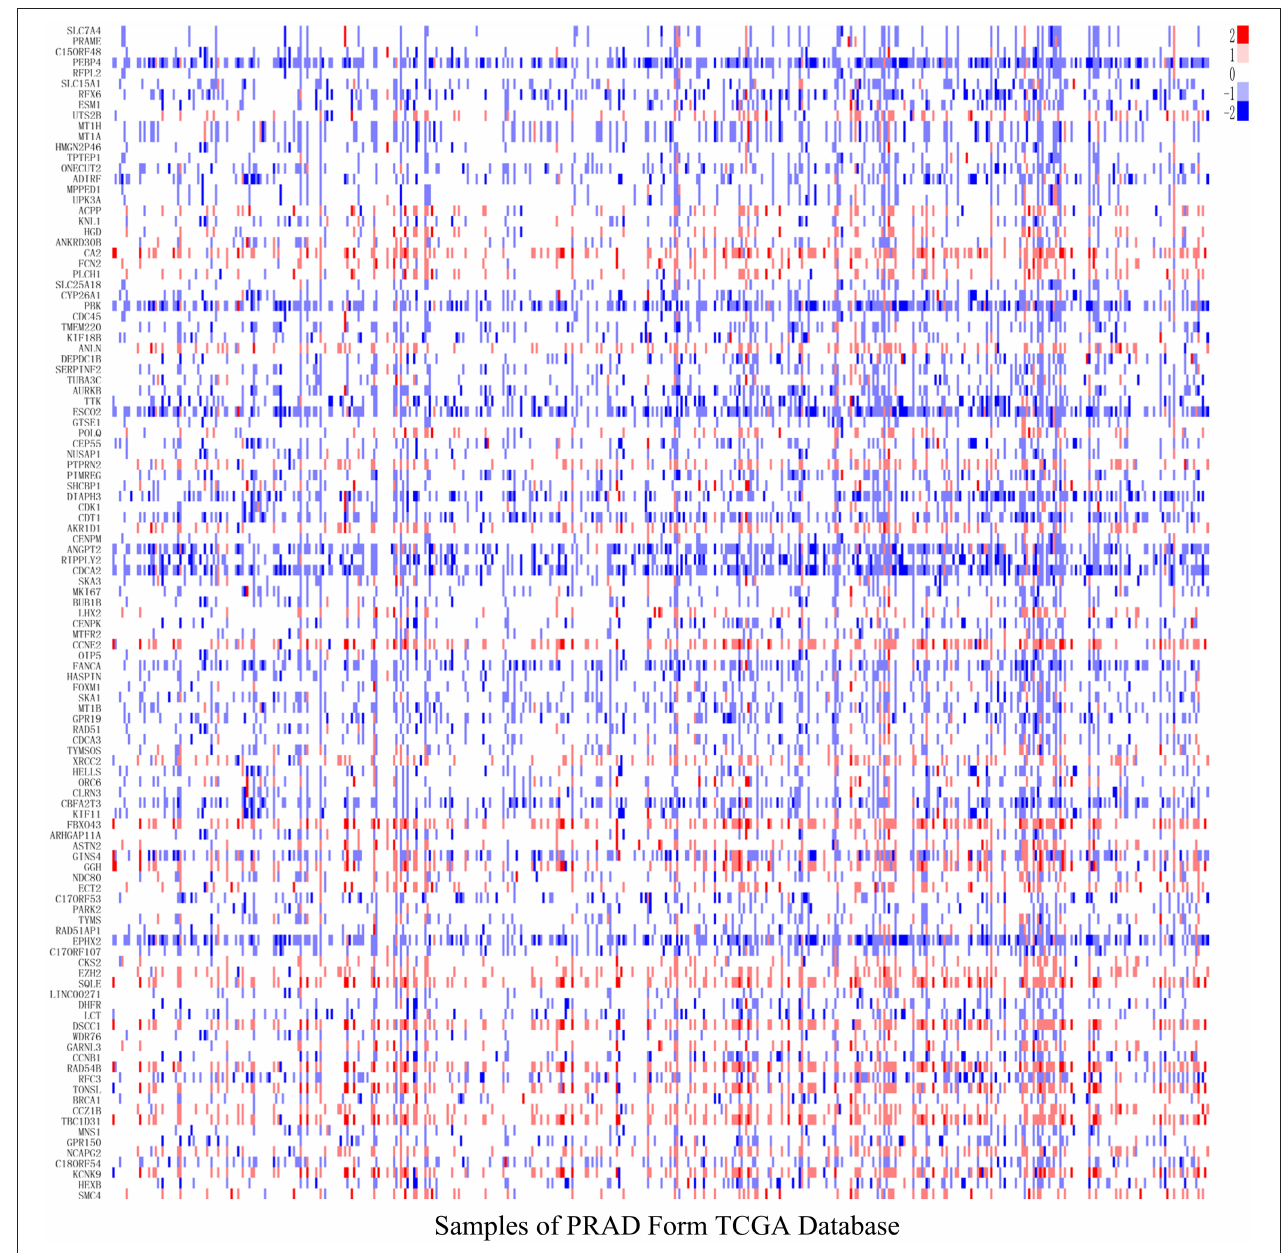
FIGURE 3 | The level of gene copy number in PRAD samples. The estimated values –2, –1, 0, 1, 2, respectively representing homozygous deletion, single copy deletion, diploid normal copy, low-level copy number amplification, and high-level copy number amplification. The horizontal axis represents PRAD tumor samples in TCGA, whereas the vertical axis represents genes from M7 module with CNV >